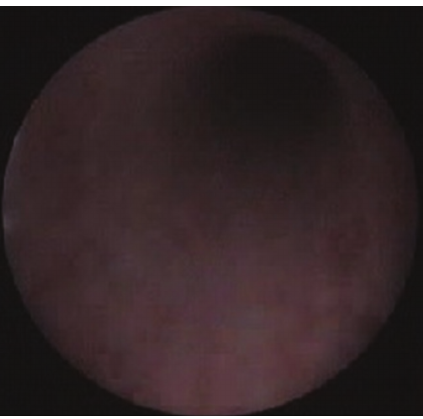
Figure 4: View of the ureter before intraurethral BCG